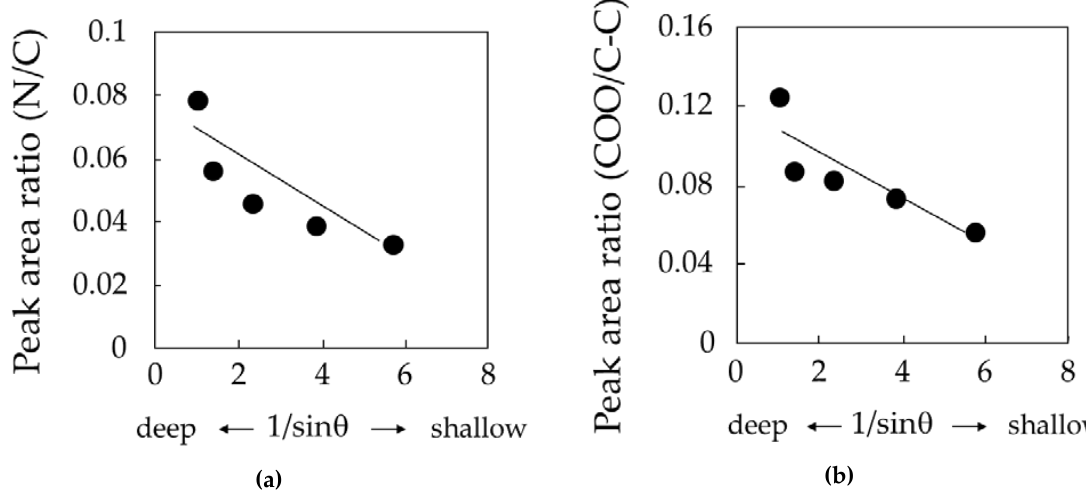
Figure 8. Molecular orientation analysis of 18-MEA/SPDA membrane by angle resolved X-ray photoelectron spectroscopy (ARXPS). ( a ) Angle dependence of N(Nitrogen)/C(Carbon) concentration derived from SPDA. ( b ) Angle dependence of COO(carboxyl)/C(Carbon) concentration derived from 18-MEA.